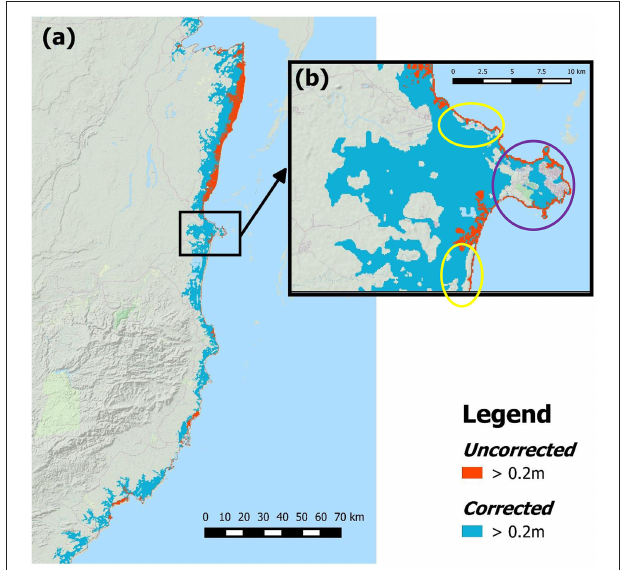
FIGURE 2 | Differences in modeled flood extent (depth > 20cm) for a simulated category five hurricane storm surge along the Belizean coast using raw vs. vegetation bias corrected SRTM DEMs. (a) Shows the entire Belizean coast; (b) details the Belize City region.